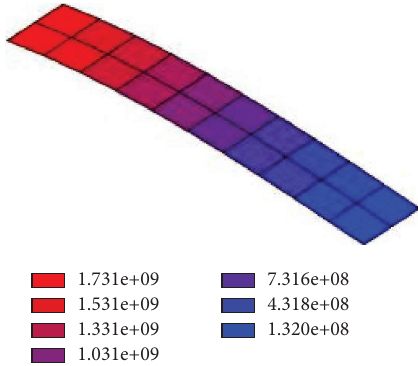
Figure 10: Von mises stress contours of the long cantilevered plate at the time of